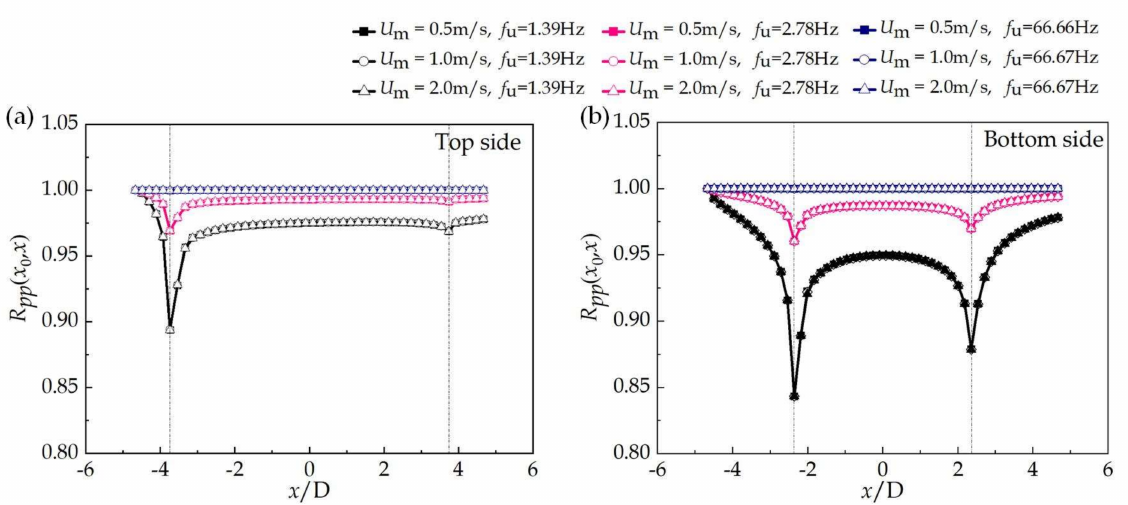
Figure 10. Streamwise correlations of pressure coefficients with different U m values in streamwise sinusoidal flows: ( a ) top side; ( b ) bottom side.